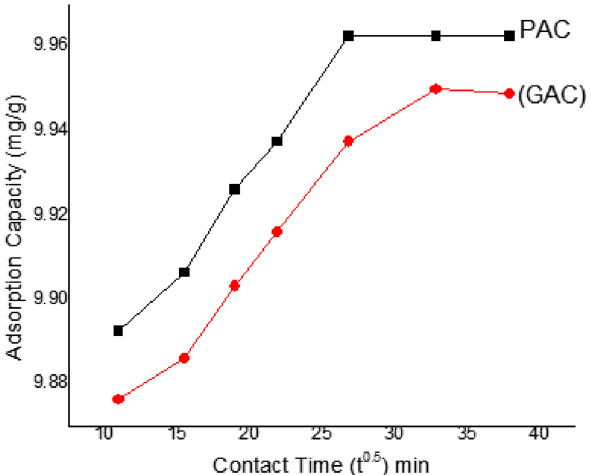
Fig. 7 Hg(II) removal (%) versus Hg concentration (mg/L) for pow- dered activated carbon (PAC) and granular activated carbon (GAC) at 30 min. contact time, 20 g adsorbent, pH = 6.05